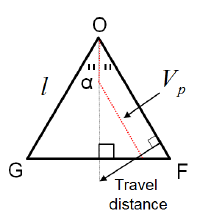
Figure 3. Detonation front plane and the liner projection